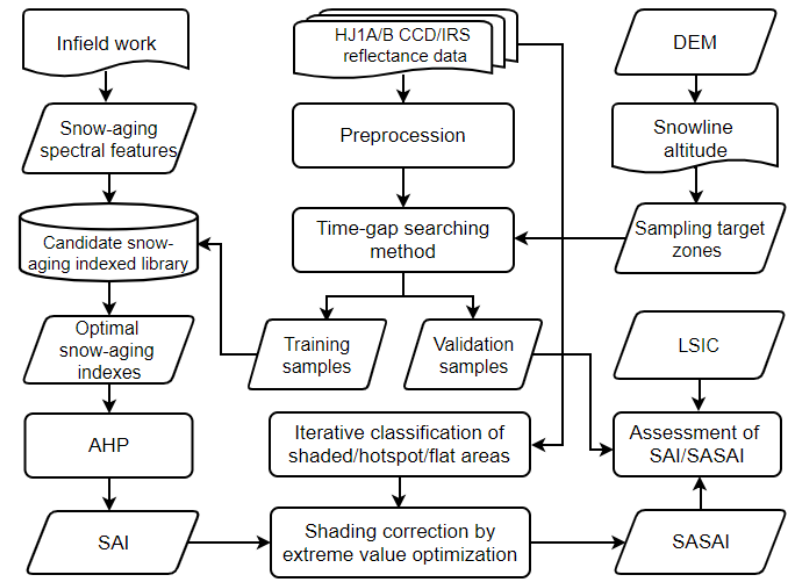
Figure 2. Flowchart of SASAI generation in this study.